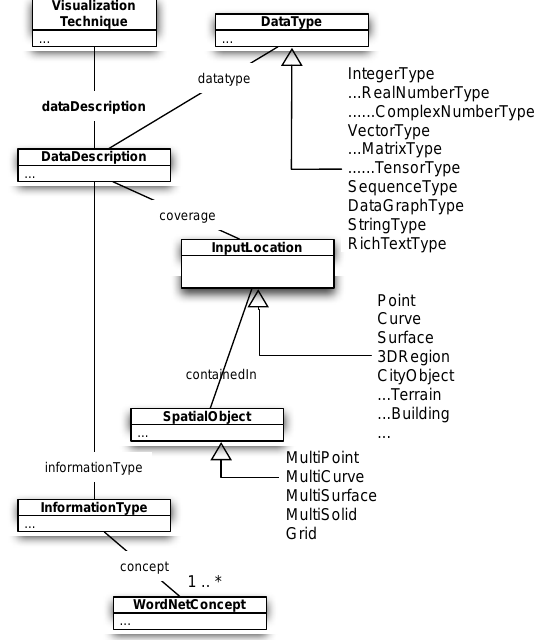
Figure 1. DataDescription representation